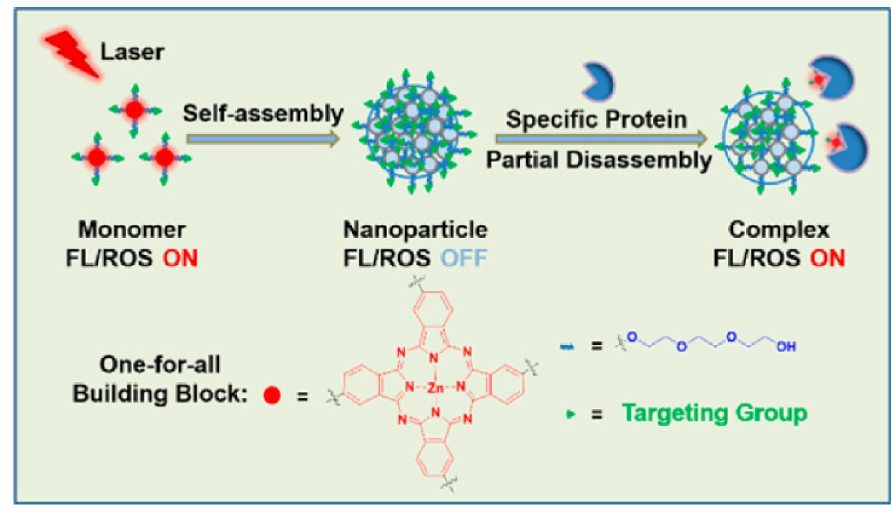
Scheme 4. Schematic illustration of the biotin-decorated PEGylated ZnPcs (FL—fluorescence, ROS—